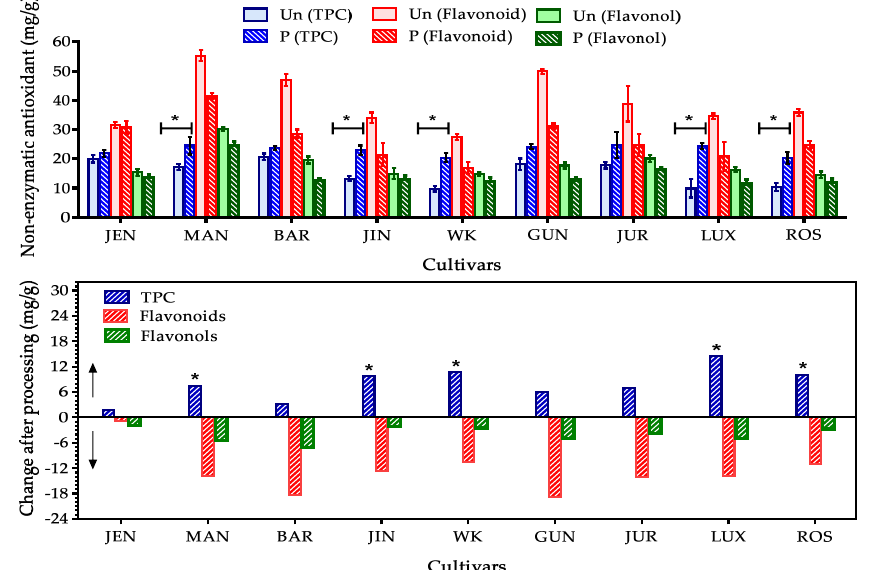
Figure 3. TPC, total flavonoids and flavonols contents of nine cultivars of lupin flour. The TPC, total flavonoids and flavonols contents of nine cultivars of lupin flour before and after processing. Values were represented as mean ± SEM where number of replicates was 3. ↔ Signified comparison of mean of processed vs. unprocessed flours. * Significance at p < 0.05 (unprocessed vs. processed condition). Upside arrow on top panel signified increase of TPC whereas downside arrow on bottom panel signified decrease of flavonoid and flavonol in processed flour compared to unprocessed one.